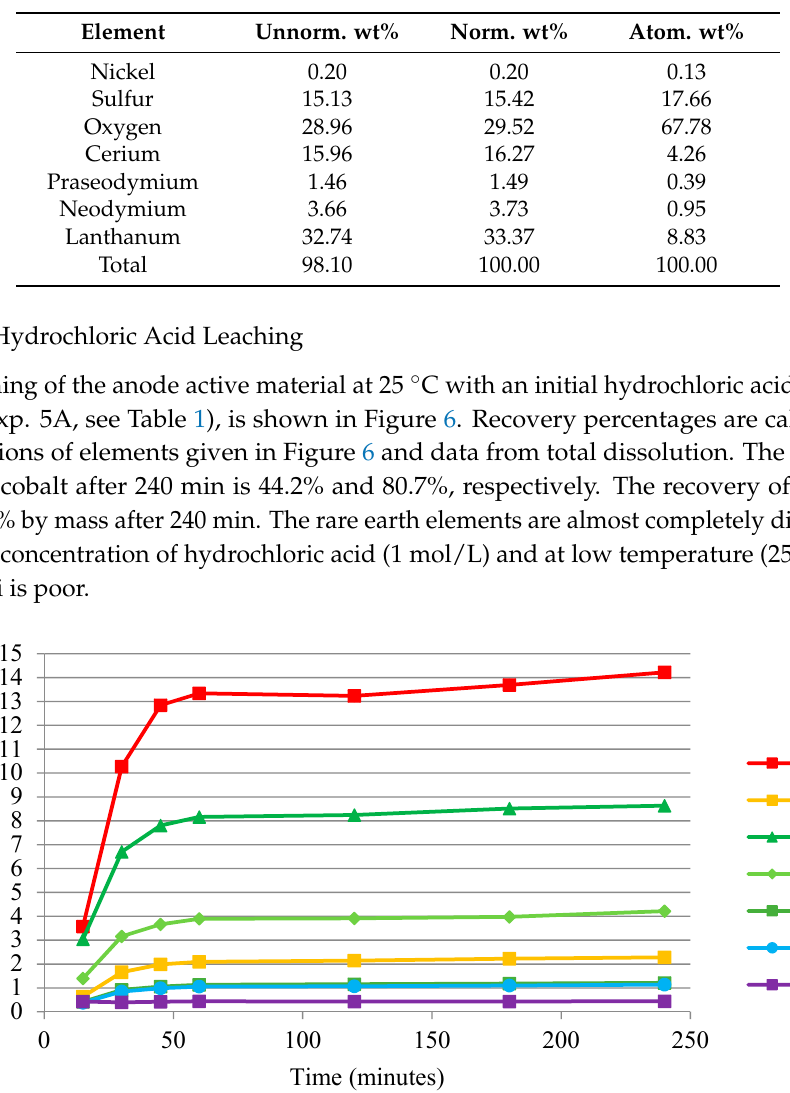
Table 7. EDS results of point analysis of precipitate on the red mark on the left figure.